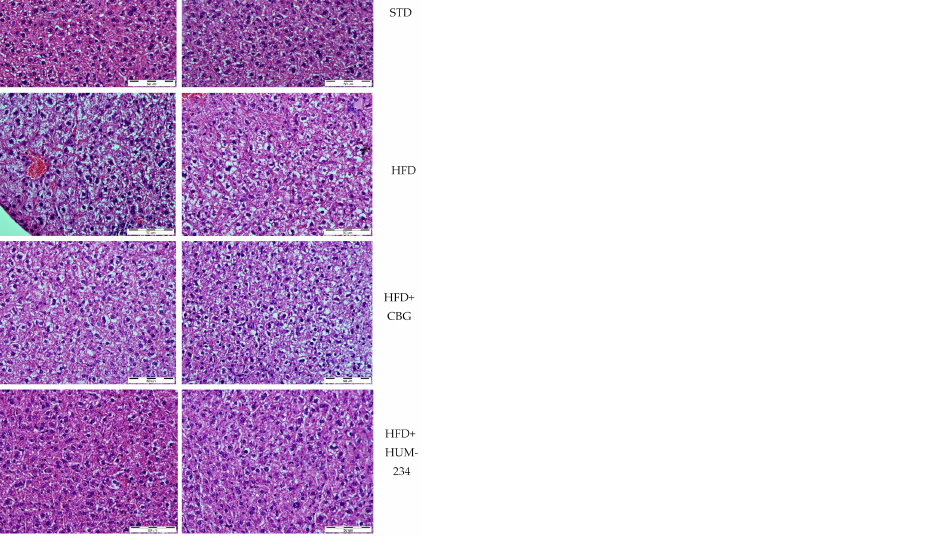
Figure 8. Liver steatosis in HUM-234 (25 mg/kg) in comparison to CBG (15 mg/kg), HFD (high-fat diet) and STD (standard food diet). Magnification 40 × , bar length 50 µ